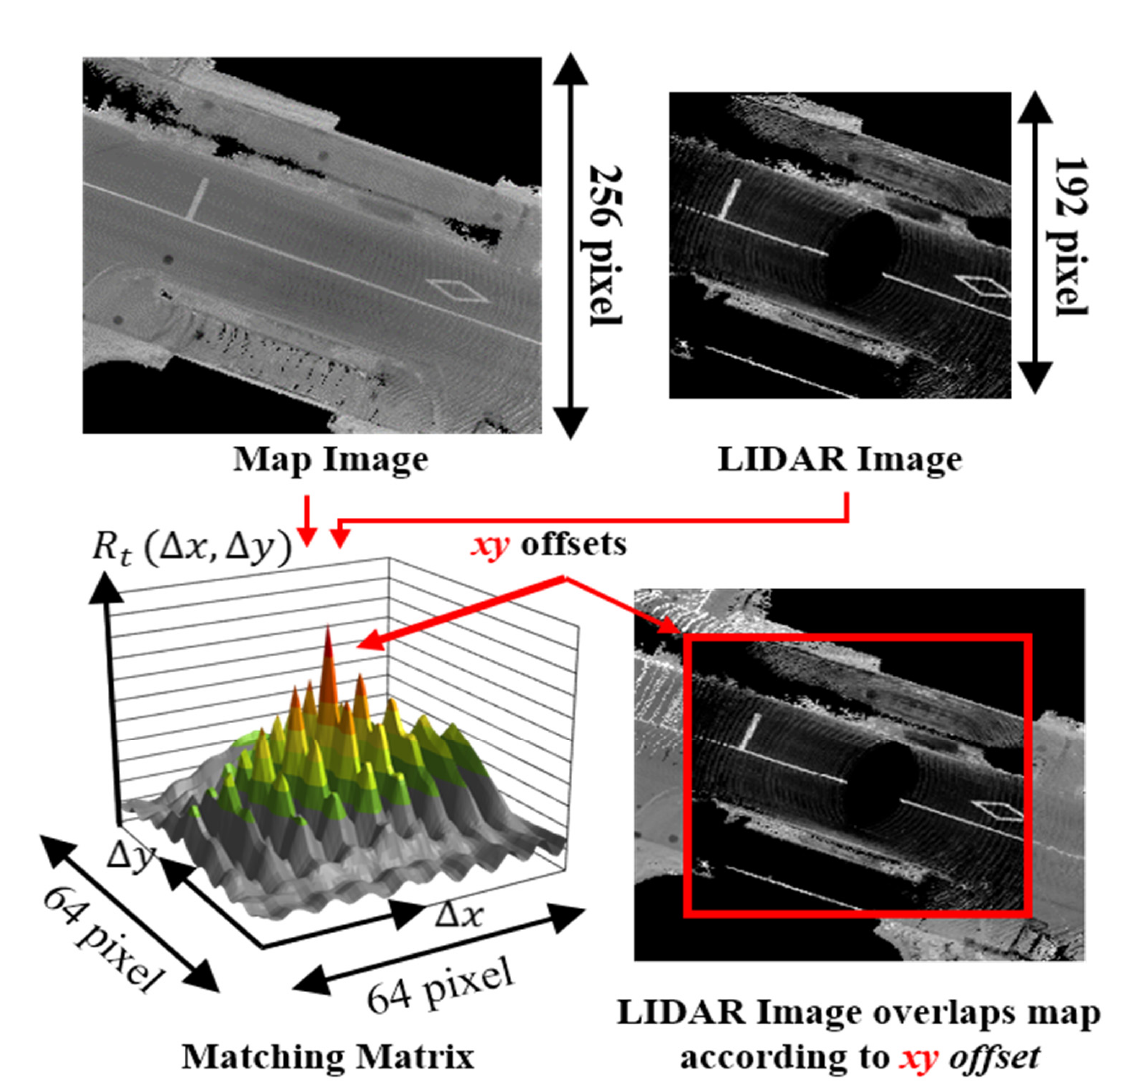
Figure 6. LSM based localization system in XY plane. Lateral and longitudinal offsets are first calculated in XY plane using image matching between intensity map and LIDAR images.